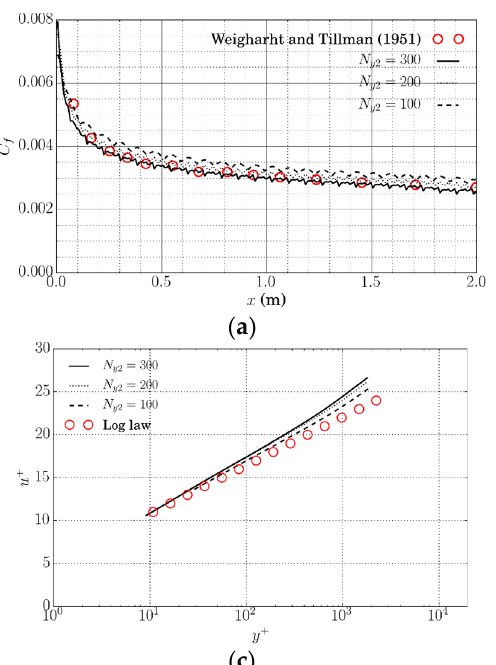
Figure 5. Sketch of the rotated (stretched) mesh for turbulence flow over a flat plate.